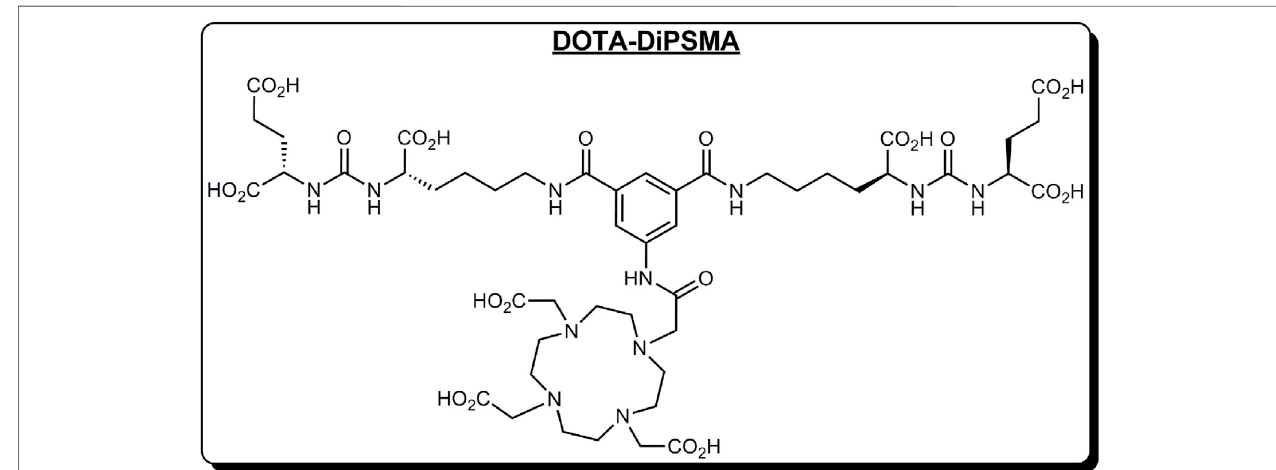
FIGURE 1 | Structure of